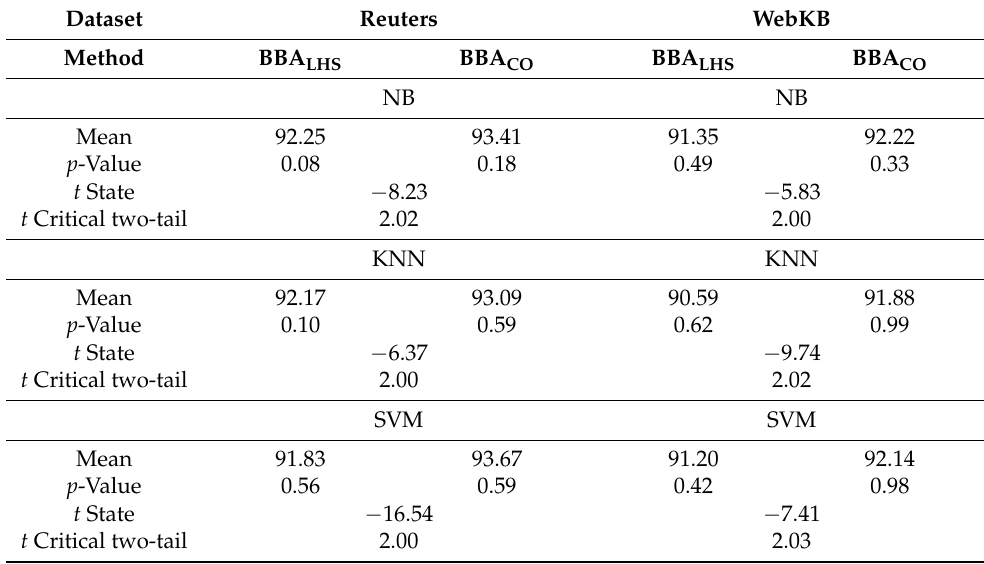
Table 15. The t -test of classification results of BBA CO vs. BBA LHS methods.